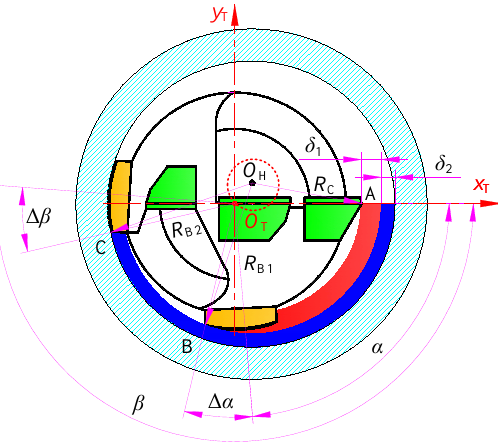
Figure 3. Geometric parameter relationship of staggered tooth BTA deep hole drilling.